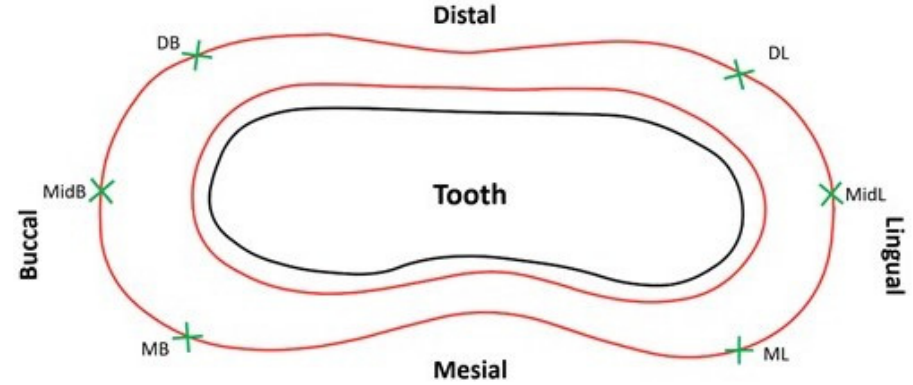
Figure 2. Six marginal fit evaluation sites around the periphery of the tooth.